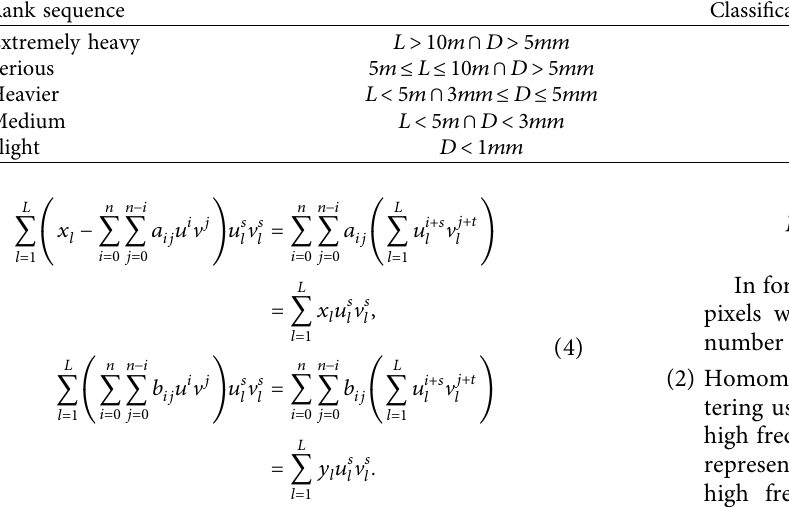
Table 1: Evaluation grade table of tunnel lining